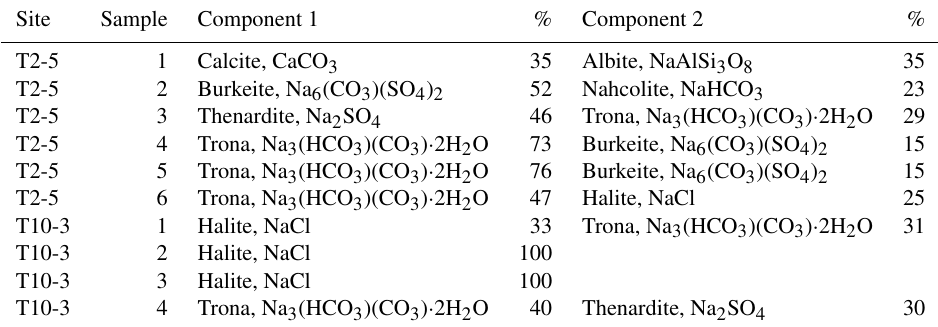
Table 13. List of the most and second-most abundant salt species in crust samples taken at sites T2-5 and T10-3. The full data set is available in Lasser and Karius (2020).